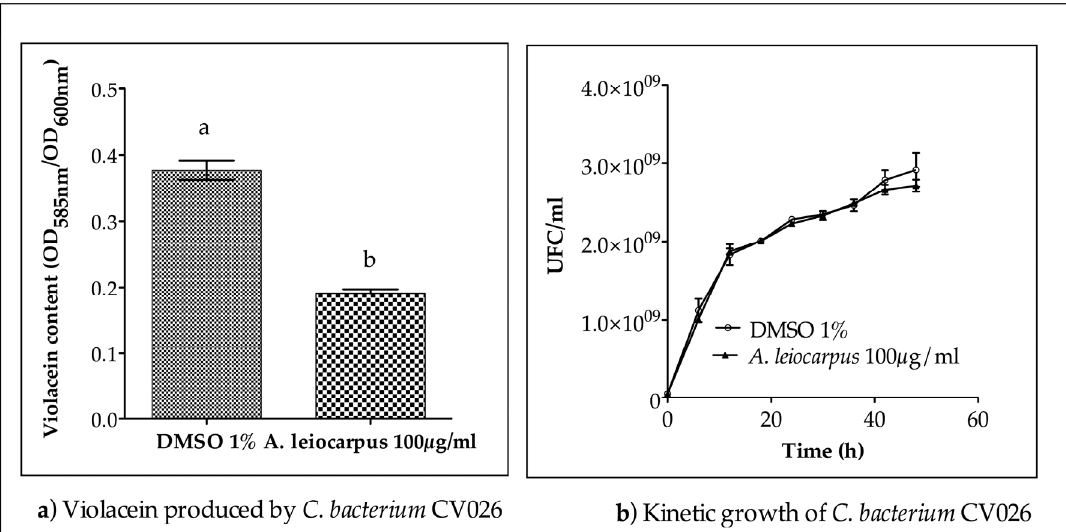
Figure 2. Anti-quorum sensing (QS) activity of methanol extract from A. leiocarpus . ( a ) A. leiocarpus extract (100 µ g/mL) significantly reduces ( p > 0.05) violacein production by C. violaceum CV026 within 48 h ( b ) A. leiocarpus extract (100 µ g/mL) did not exhibit a significant effect of on C. violaceum CV026 kinetic growth within 48 h. Dimethyl sulfoxide (DMSO) was used as a negative control. C. violaceum CV026 was grown (30 ◦ C, 175 rpm agitation) in LB broth supplemented with HHL (10 µ M in DMSO). Mean values of triplicate independent experiments and SD are shown. Data with different letters in superscript are significantly different ( p > 0.05).